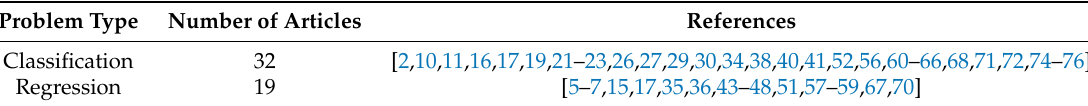
Table 1. Articles that used supervised learning in their deep learning